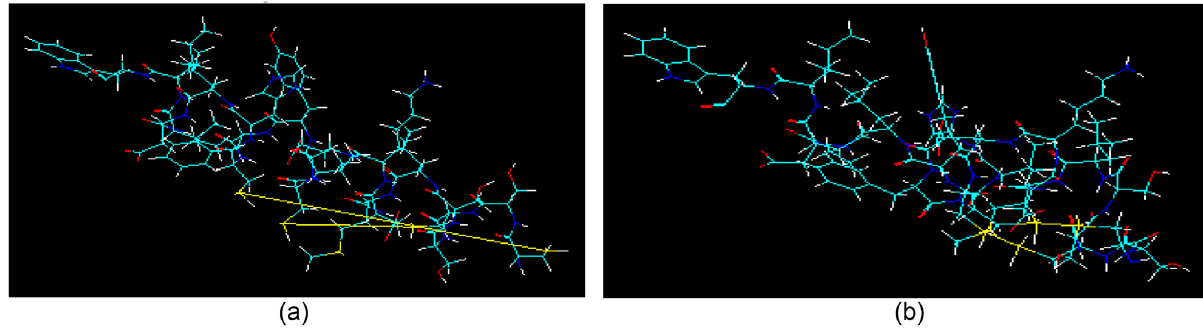
Figure 6: ET - I Models and S – S bonds formation: ( a ) ET - I model cyclized between AA, Cys – Cys at 1 – 15, and 3 – 11 of sulfur residues ( yellow connections ) , cyclization bonding shown as two yellow lines; ( b ) an energy minimized model of A after 5,100 cycles, Monte - Carlo simu - lations, the S – S bond lengths reduced and two cyclic loops generated.